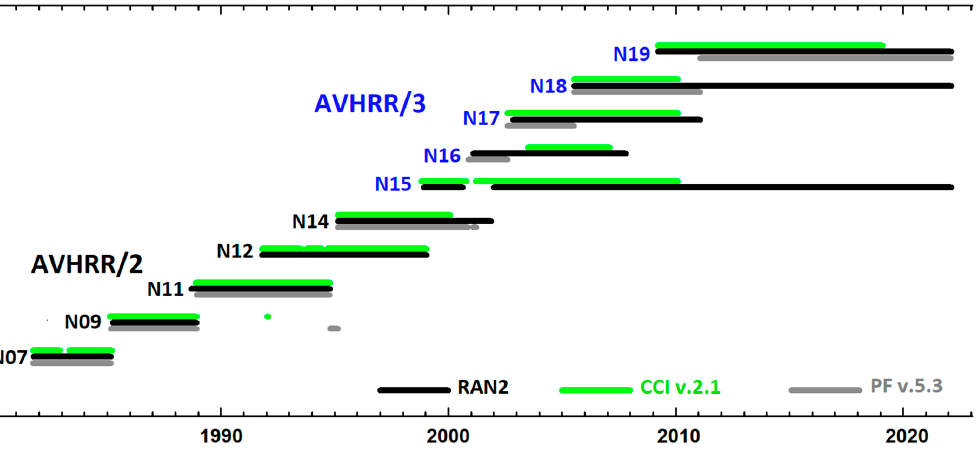
Figure 4. NOAA satellites and periods of data processing in RAN2, CCI, and PF datasets.